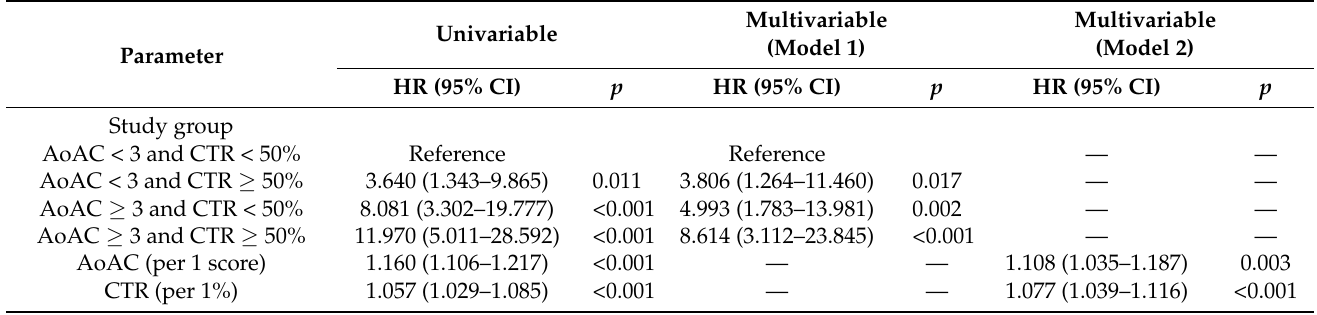
Table 3. Determinants of cardiovascular mortality using Cox proportional hazards model in study patients.